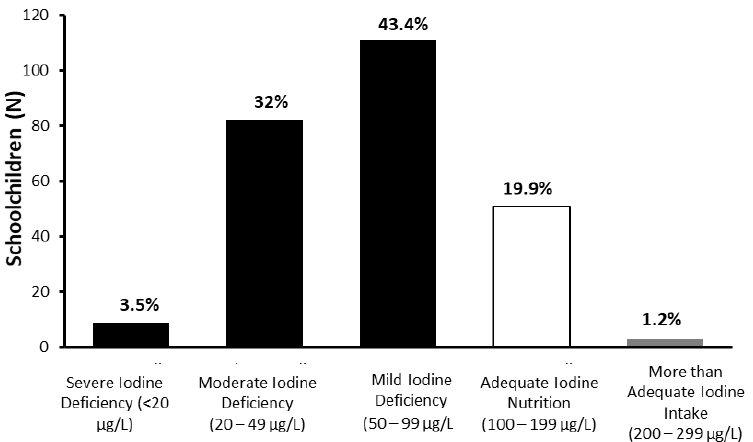
Figure 2. Schoolchildren distribution according to iodine status (median UIC= 66.2 µ g/L, n = 256).